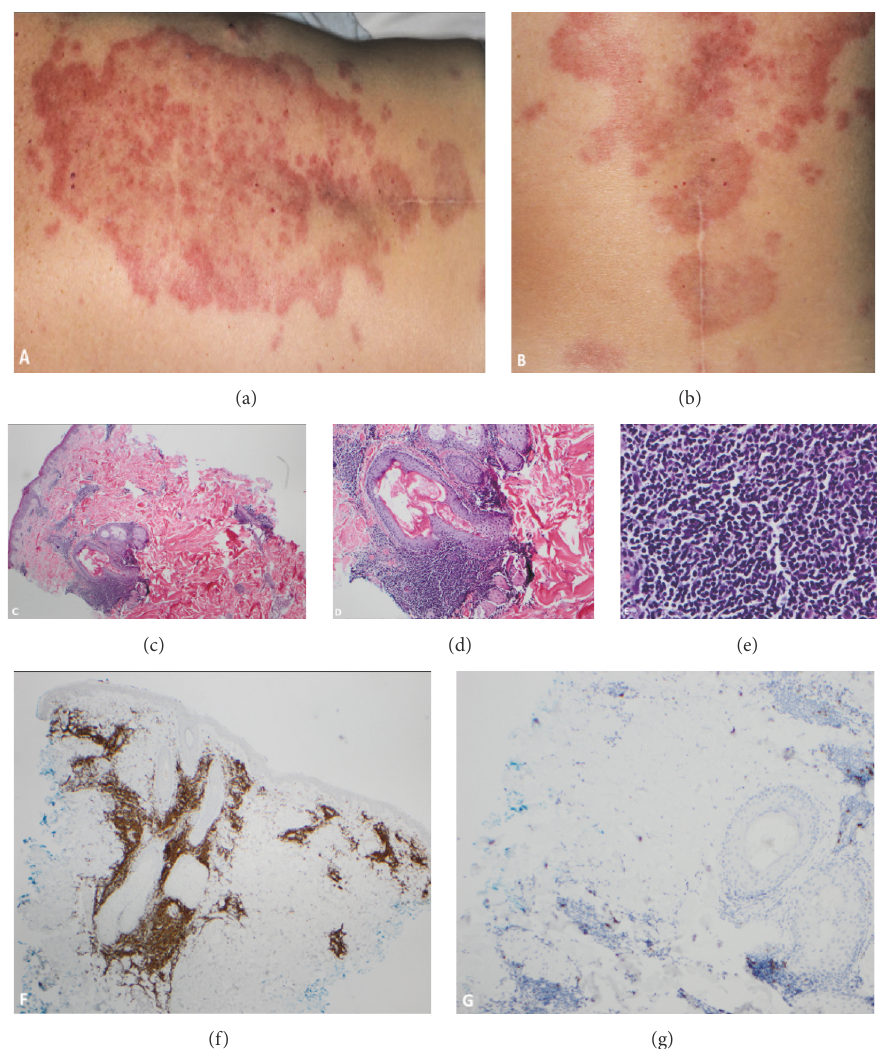
Figure 2: Annular erythematous maculopapular lesions on the upper and lower back (a, b). Dermal infiltration of small-to-medium-sized mature lymphocytes with periadnexal and perivascular distribution (c, d, e). These lymphocytes reacted predominantly with CD3 (f) and CD5 (not shown); only rare lymphocytes were positive for CD20